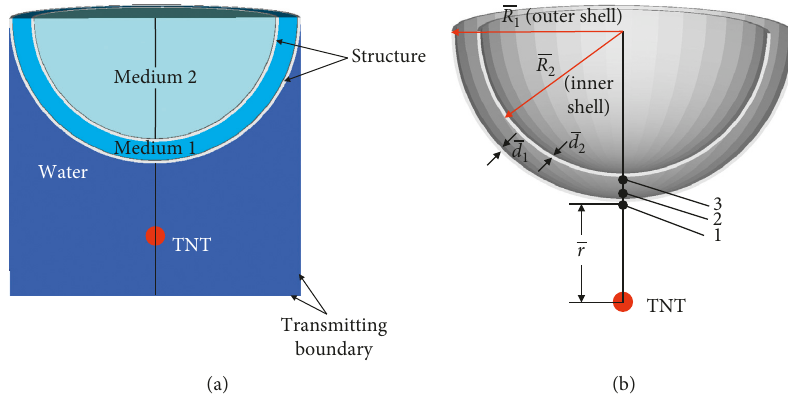
Figure 9: Numerical model and the arrangement of measuring points. (a) Numerical model. (b) Model size and measuring